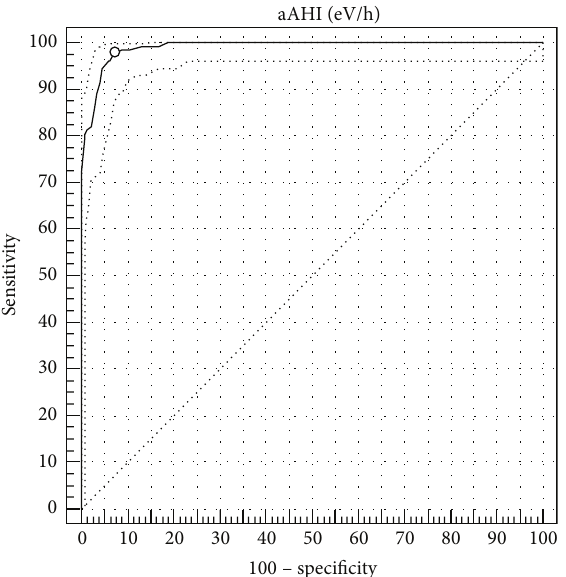
Figure 3: Comparison between mAHI and aAHI ( ≥ 30eV/h).